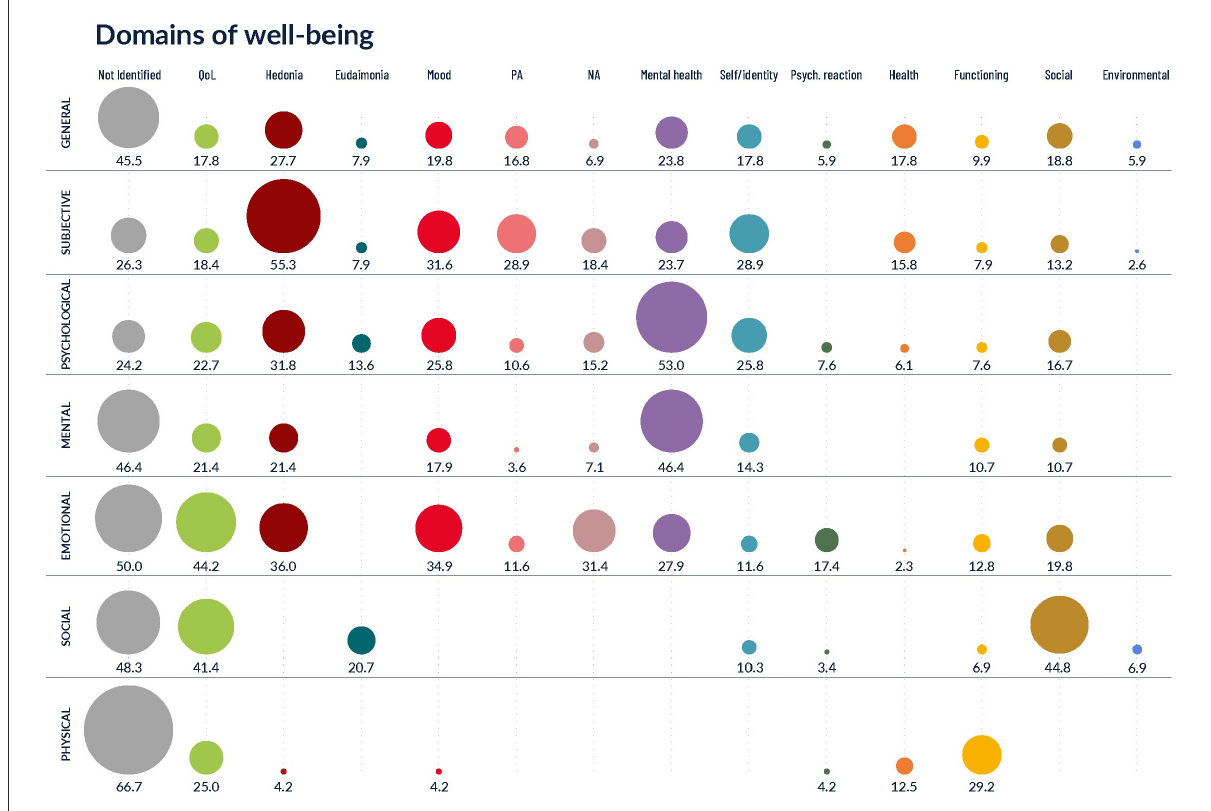
FIGURE2 Overview of the prevalence of domains (in %) for the main types of well-being (listed in > 20 articles).